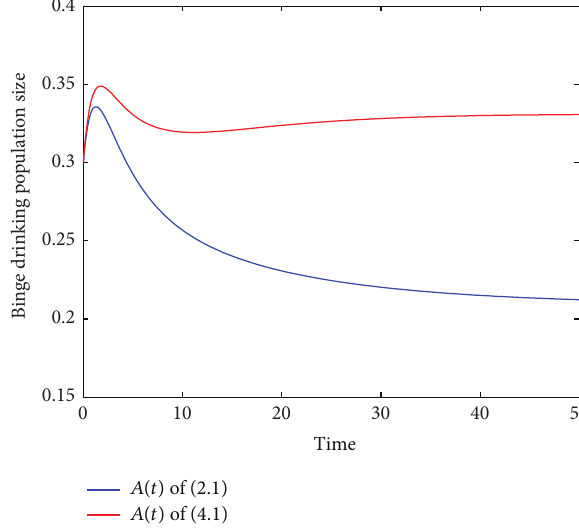
Figure 5: Variations of the binge drinking population 𝐴(𝑡) of (2) and